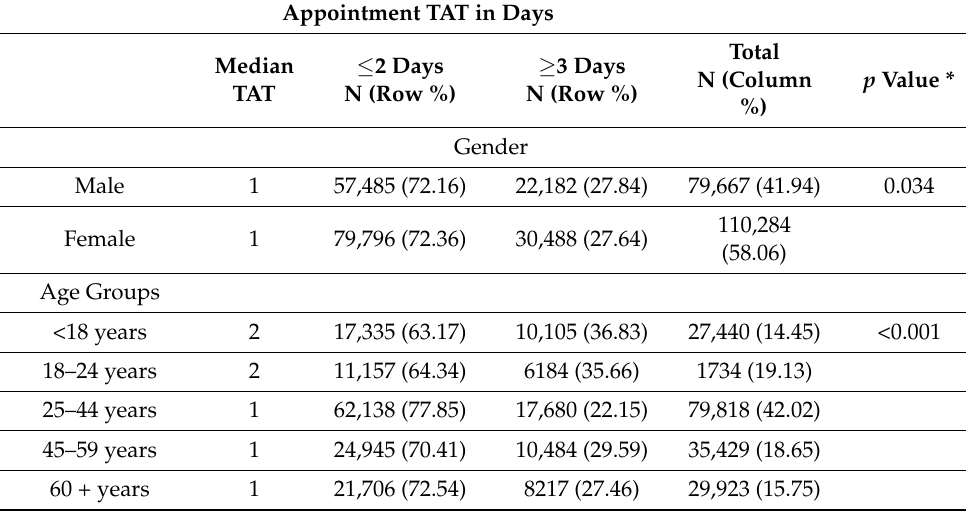
Table 3. Patient and visit characteristics of patients who completed a telehealth visit at DHA, by turnaround time (TAT), March 2020–July